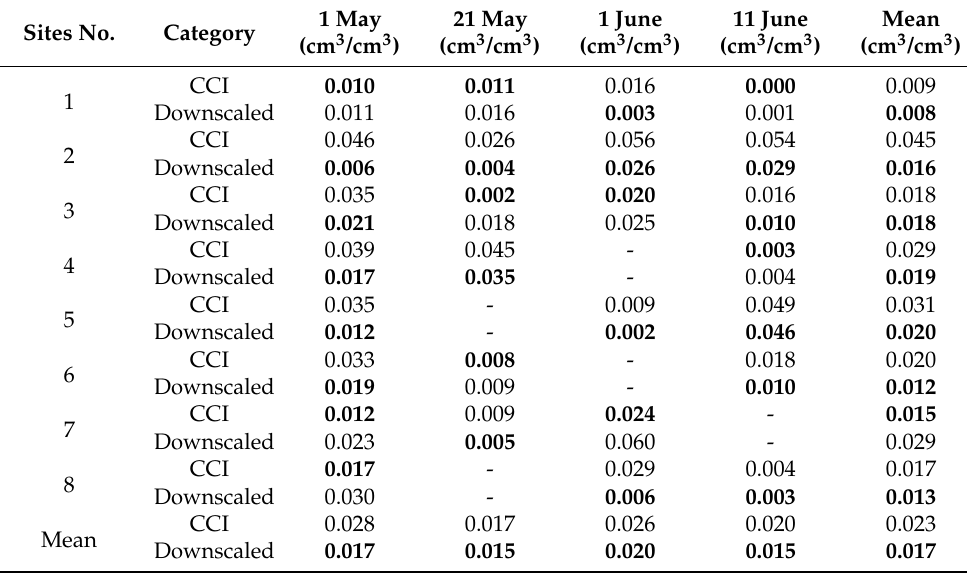
Table 3. Statistical comparisons of average absolute difference (AAD) values between the original CCI SM data or the downscaled CCI SM data and in situ SM dataon1 May, 21 May, 1 June, and 11 June. The lower AAD values are noted in